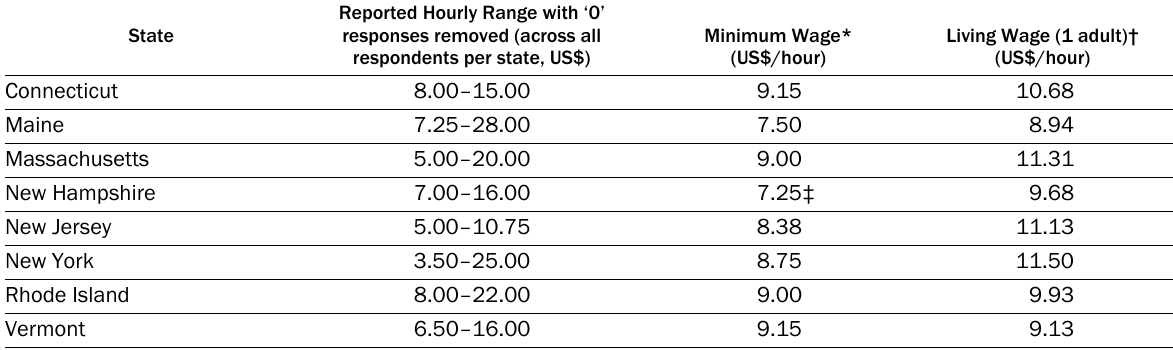
Table 4. Reported Hourly Range, Minimum, and Living Wage by State (All in US$) State